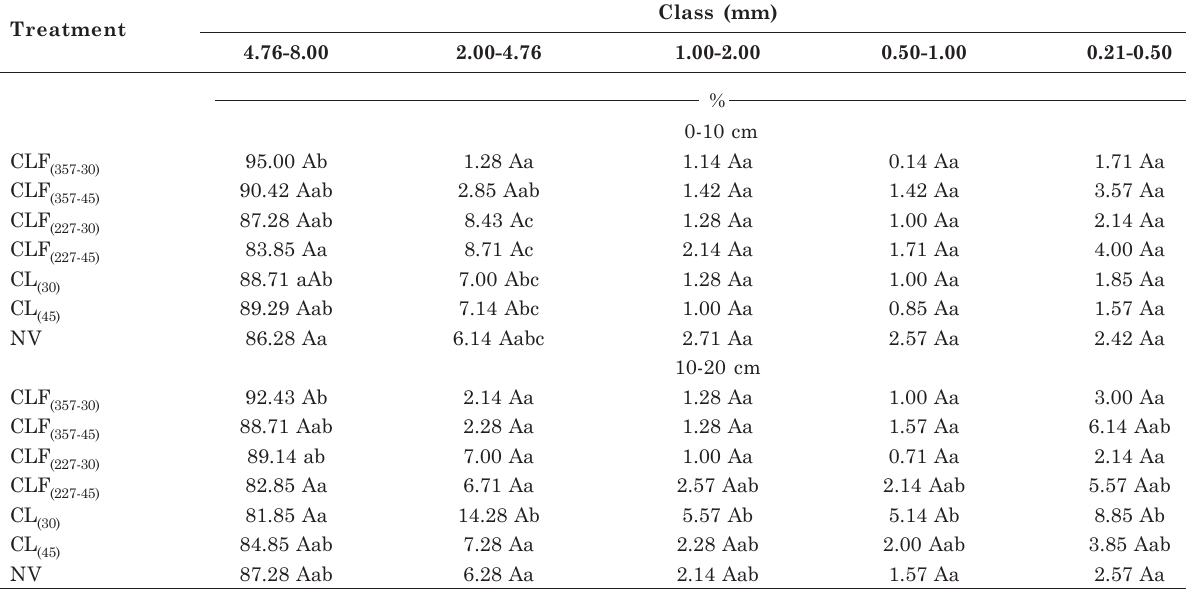
Mean values with the same uppercase letter at the depth, and lowercase letter in the treatment do not differ among themselves in the LSD test (p<0.05).